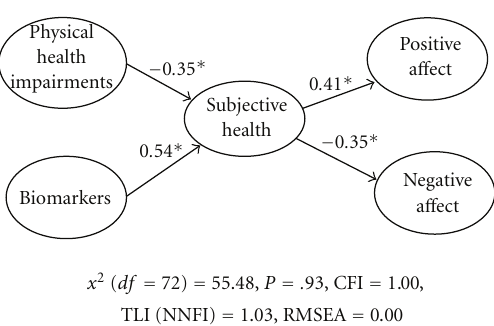
Figure 1: The latent variable relationship between physical health impairment and psychological well-being. Note. Path coe ffi cients are standardized parameter estimates and direct loadings are displayed in solid lines. ∗ P < .